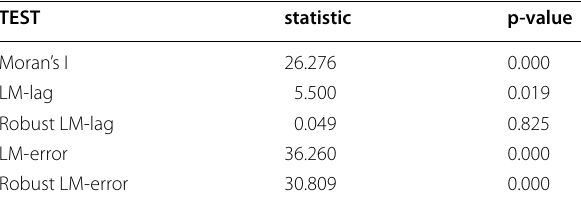
Table 2 Spatial diagnostic test Table 3 Regression results of urban floating